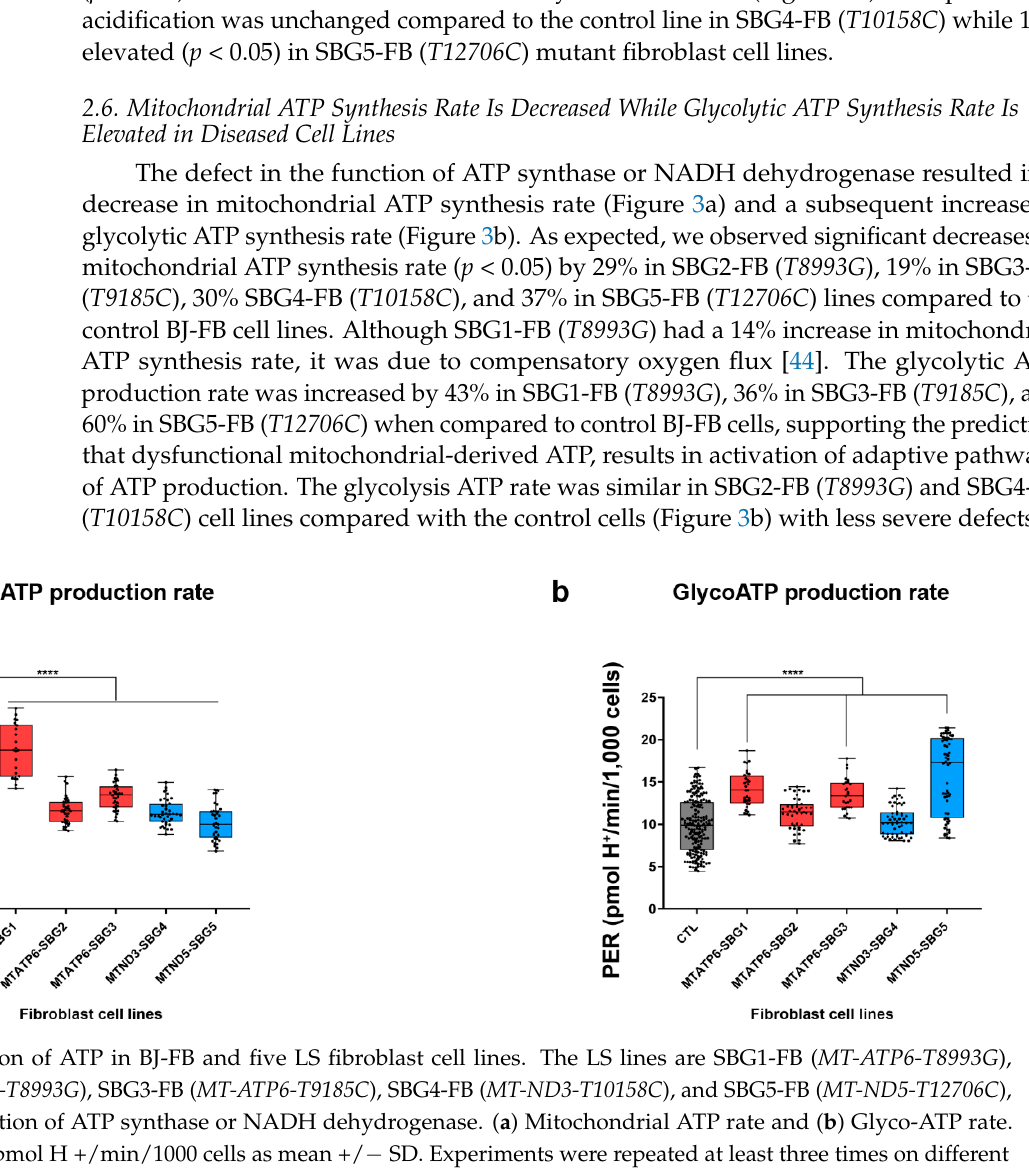
Figure 2. Glycolytic profile of CTL BJ-FB and five LS fibroblast cell lines. ( a ) a real-time profile shows the glycolytic acidi- fication; PER of BJ-FB and diseased (SBG1-FB (MT-ATP6-T8993G), SBG2-FB (MT-ATP6- T8993G), SBG3-FB (MT-ATP6- T9185C), SBG4-FB (MT-ND3-T10158C), and SBG5-FB (MT-ND5-T12706C) cell lines showing ( b ) basal glycolysis ( c ) glyco- lytic capacity after ETC blocking using Rot/AA ( d ) post 2-DG (non-glycolytic acidification). Data are shown in pmol H + /min/1000 cells as mean +/- SD. Experiments were repeated at least three times on different days under the same condi- tions. * p < 0.05 **** p < 0.0001. Comparative analyses for all diseased (SBG1-5) FBs were conducted with the healthy control BJ-FB line. PER: proton efflux rate.